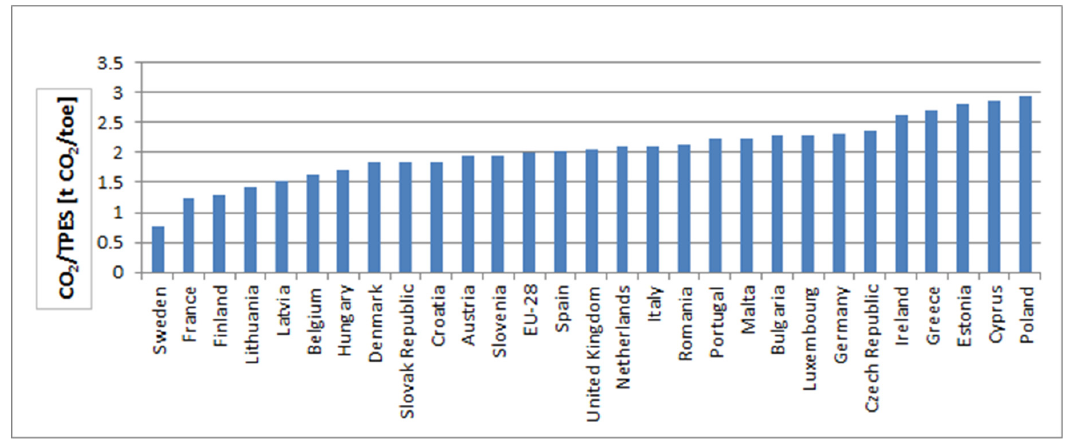
Figure 1. Emission indicator of CO 2 / TPES in EU countries in 2017. Source: Authors’ calculations based on [8].